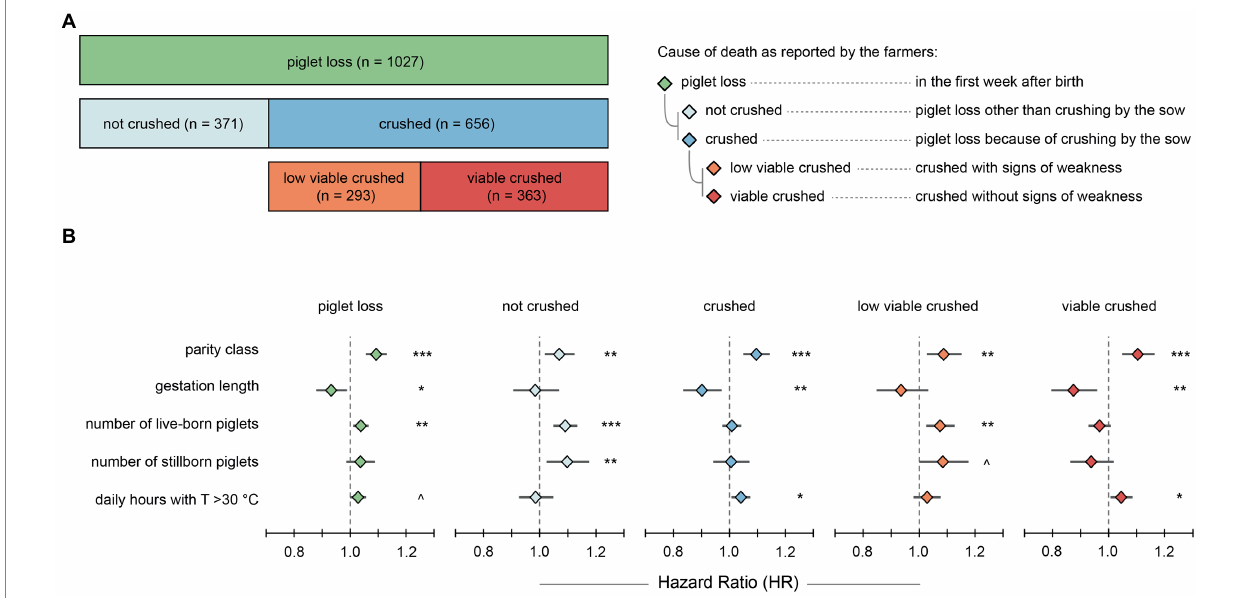
FIGURE 1 (A) Differentiation of the events for the number of piglets that died in the first week after birth. The bar on top represents all piglet losses , the bars in the middle the differentiation of the piglet losses into not crushed versus crushed piglets, and the bars at the bottom the differentiation of the crushed piglets into low viable crushed versus viable crushed piglets. (B) Results of the mixed-effects Cox regression analyses for the five defined events. Estimated hazard ratios with 95% confidence interval are shown for the five co-variates (potential risk factors). Significance Code: *** p < 0.001, ** p < 0.01, * p < 0.05, ^ p <